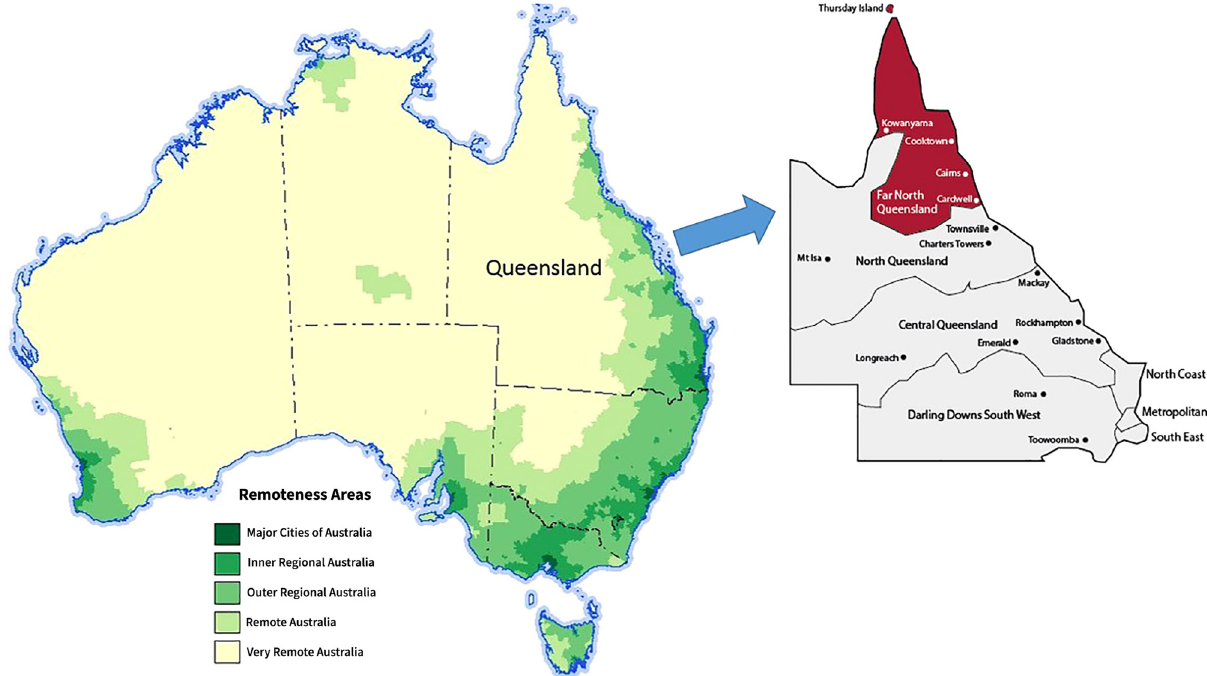
Figure 1. Map of the 2016 Remoteness for Australia. Blue arrow shows the Far North Queensland region. Retrieved from: https://www.abs.gov.au/ websitedbs/D3310114.nsf/home/remoteness+structure.